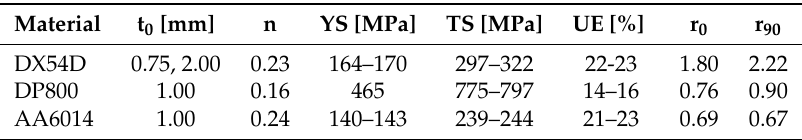
Table 1. Properties of the investigated